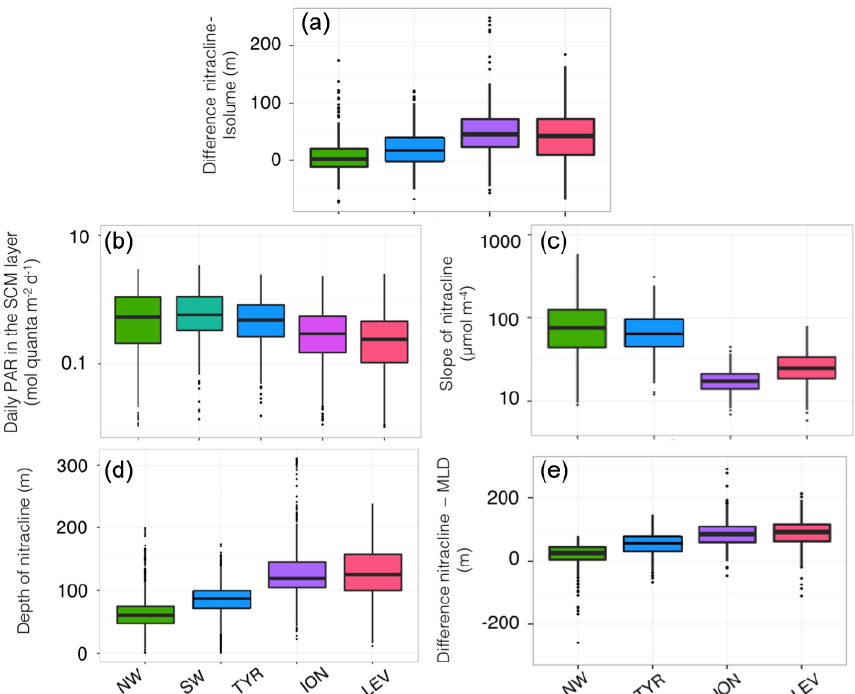
Figure 6. Box plot of the distribution for each of the Mediterranean regions considered in this study, of the difference between the depths of the nitracline 1µM and the isolume 0.3molquantam − 2 d − 1 (a) , of the daily PAR in the SCM layer (b) , the depth (c) and slope (d) of the nitracline, and the difference between the depths of the nitracline 1µM and the mixed layer depth (e) . The SW is not always represented, as there is no BGC-Argo float equipped with a nitrate sensor in this